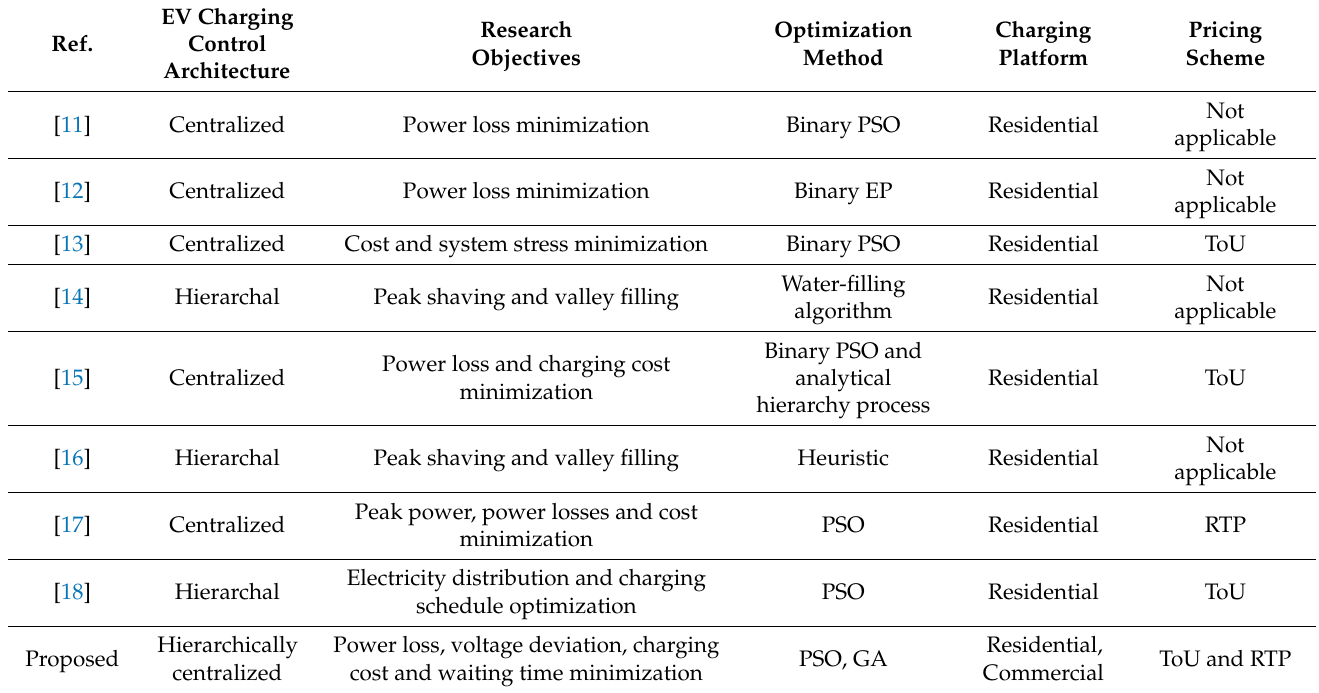
Table 1. Summary of related